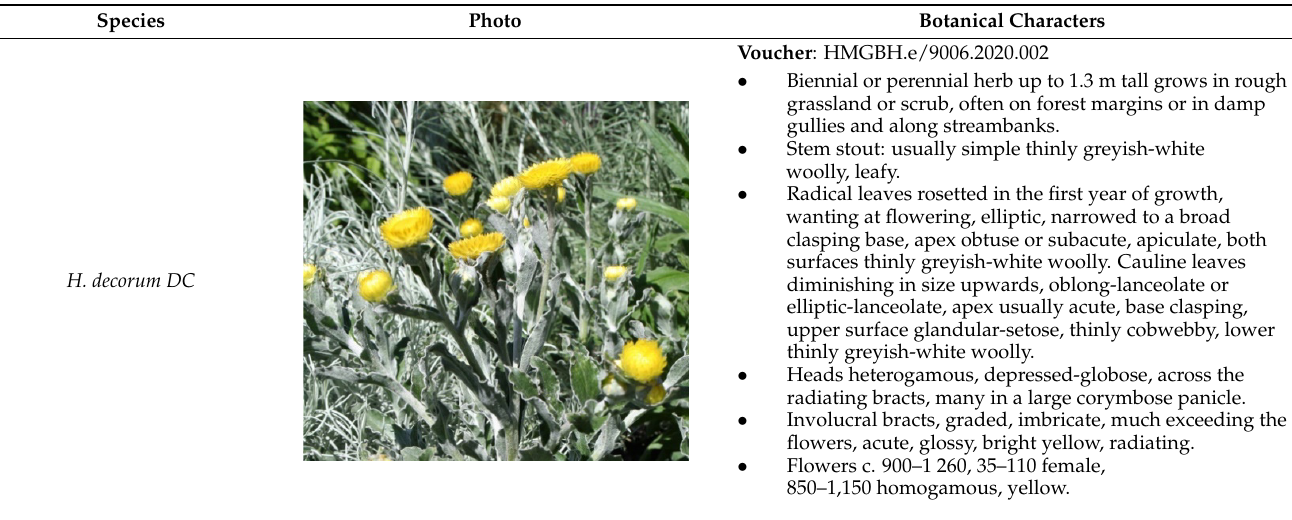
Table 3. Botanical description of the three analyzed South African Helichrysum species.